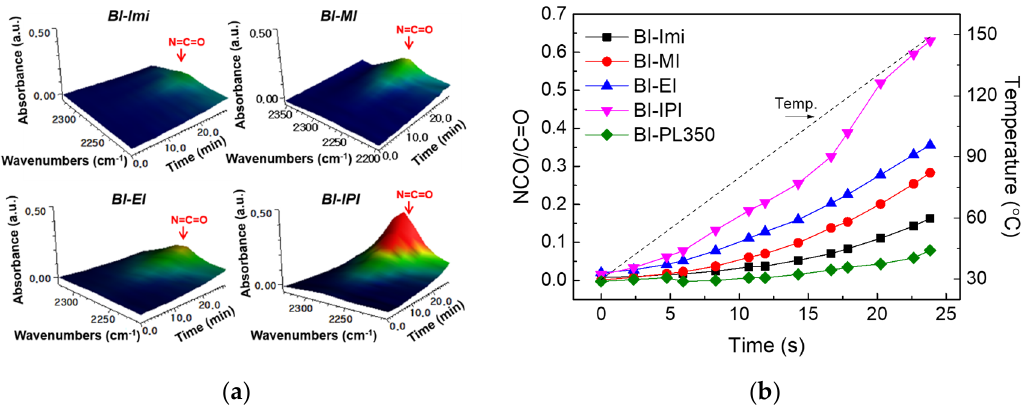
Figure 2. ( a ) 3D views of the real-time FT-IR spectra measured via Rheonaut module for imidazole-BIs in the temperature range of 30–150 °C. ( b ) Ratio of NCO/CO peaks for imidazole-BIs with increasing temperature.